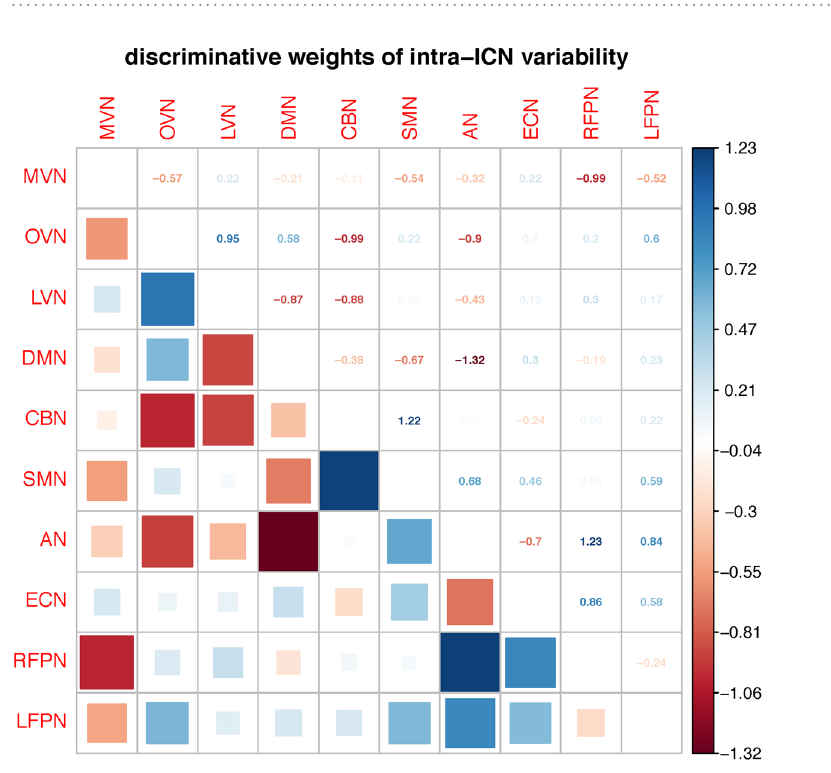
Figure 4. Discriminative patterns based on LOOCV. Red squares denote decreased inter-ICN variability in ADHD. Blue squares denote increased inter-ICN variability in